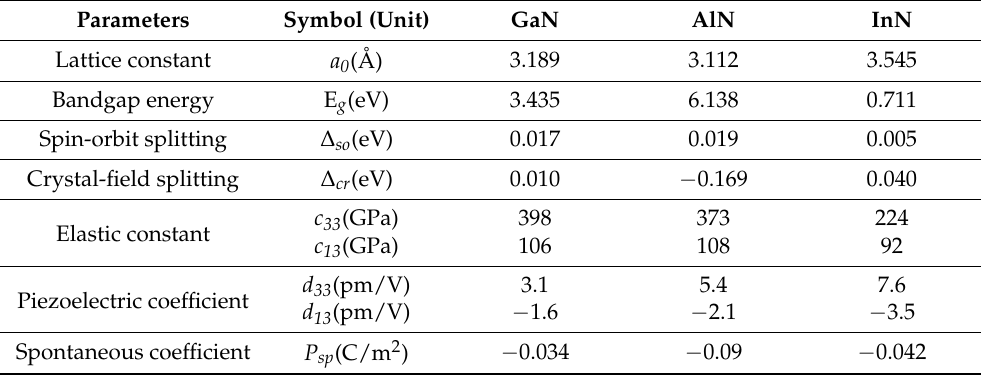
Figure 1. Schematic representation of the yellow LED epitaxial structures of sample A, sample B and sample C. Table 1. Material parameters at 300 K for wurtzite nitride semiconductors.